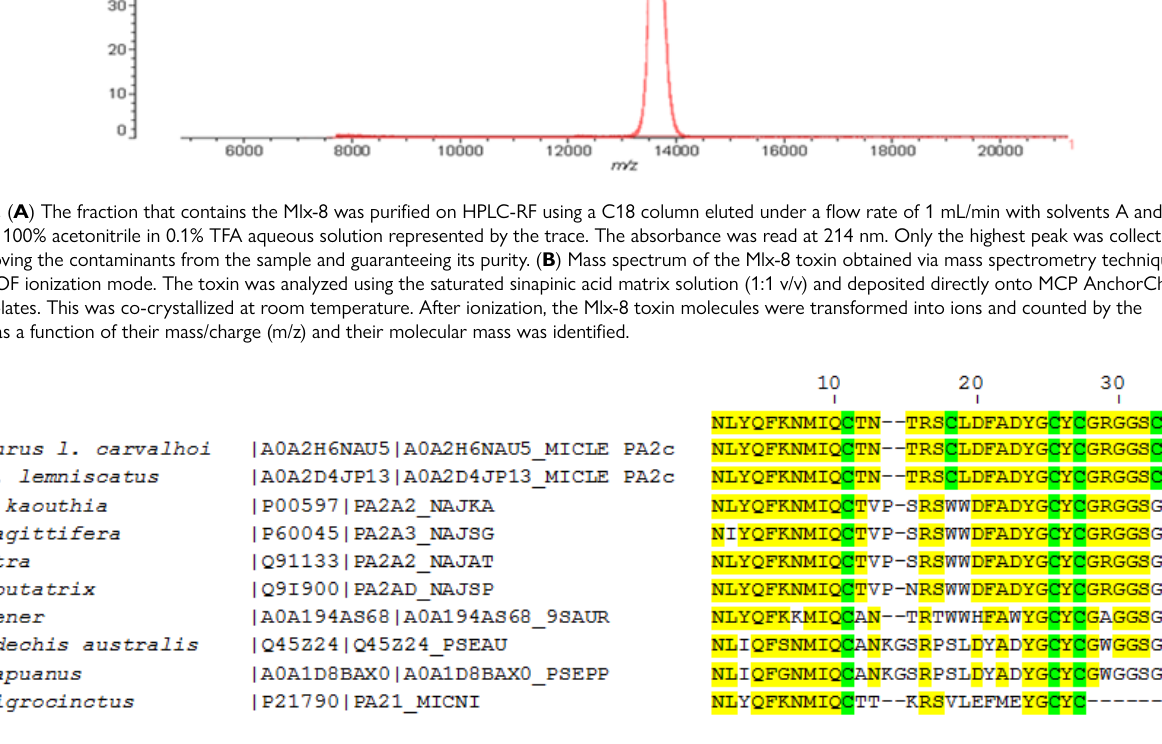
from Micrurus 2